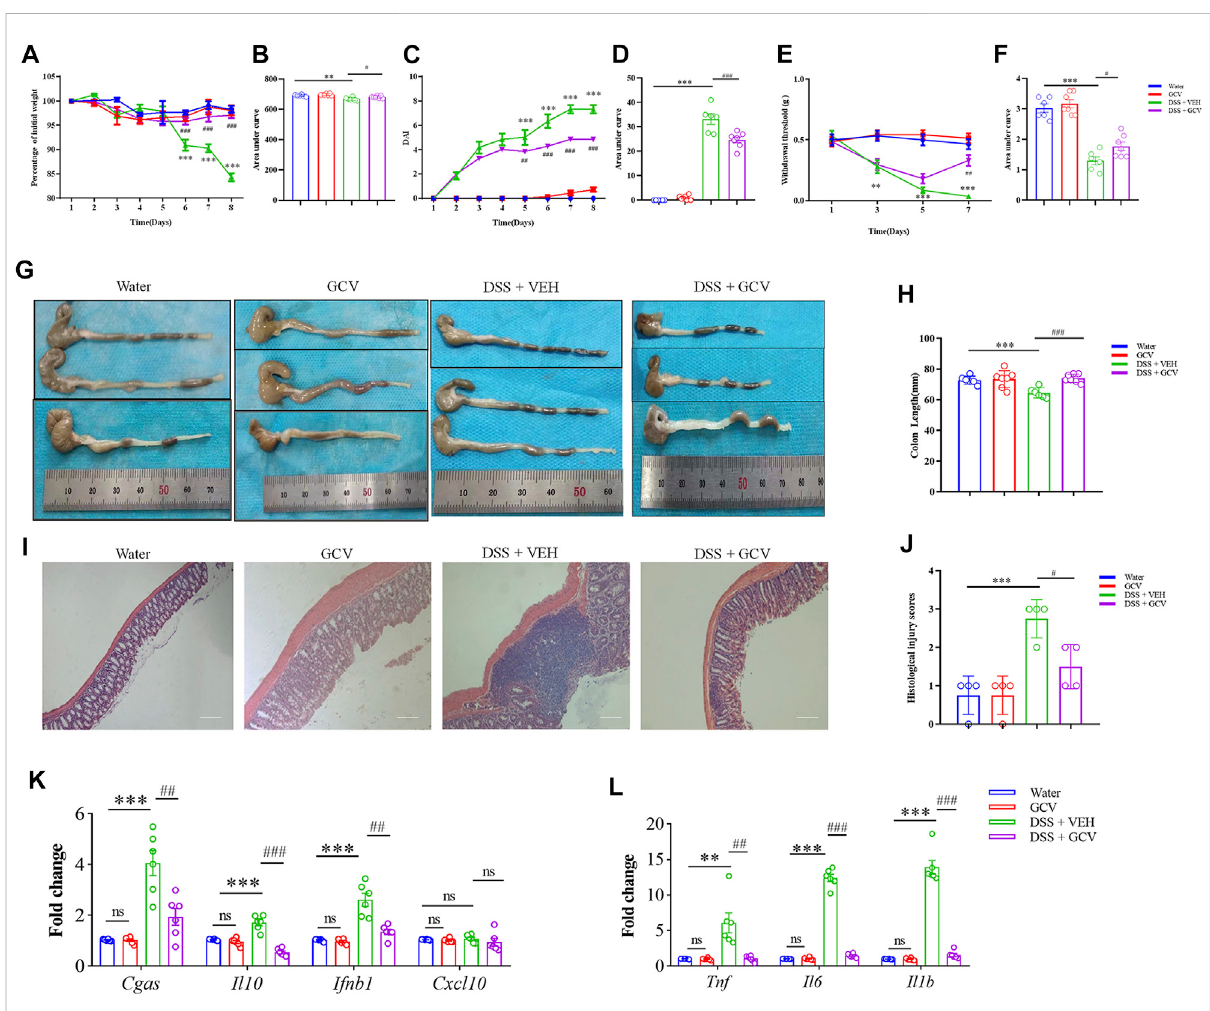
FIGURE 5 Low-doseGCVattenuatedDSS-colitisinmice. (A) DSS-colitisinducedbodyweightlossfromdifferentgroups. (B) Thequanti fi cationofAUCfor (A) . (C) DSS-colitis induced increase of DAI scores in different groups. (D) The quanti fi cation of AUC for (C) . (E) DSS-colitis induced mechanical pain hypersensitivity in the abdomen in mice from different groups. (F) The quanti fi cation of AUC for (E) . ( n = 6-7 per group; * p < 0.05, ** p < 0.05, *** p < 0.001,DSSvs.vehiclegroup; # p < 0.05, ## p < 0.01, ### p < 0.001,GCV+DSSvs.DSSgroup; & p < 0.05, && p < 0.01, &&& p < 0.001,STING gt/gt +DSSvs DSS group; two-way ANOVA with post-hoc Bonferroni test). (G) Representative pictures of colonic length from different groups. (H) Quanti fi cation ofthecolonic lengthfor (G) . ( n = 5-7each group;* p < 0.05, ## p < 0.01, & p < 0.05; one-way ANOVAwith post-hoc Bonferronitest) (I) Representative photographies of H&E staining of colon sections from different groups. (J) Statistical analysis for (I) ( n = 4 each group; *** p < 0.001, # p < 0.05, & p < 0.05;one-wayANOVAwithpost-hocBonferronitest). (K , L) TheQ-PCRanalysisofmRNAexpressionofcolonic Cgas , Il10 , Ifnb1 , Cxcl10 , Il1b , Il6 ,and Tnf inmice ofdifferentgroup( n =6pergroup,** p < 0.01,*** p < 0.001, ## p < 0.01, ### p < 0.001;unpairedStudent ’ s t -test).Alldata wasexpressed as Mean ± SEM. DSS, dextran sulfate sodium; VEH,